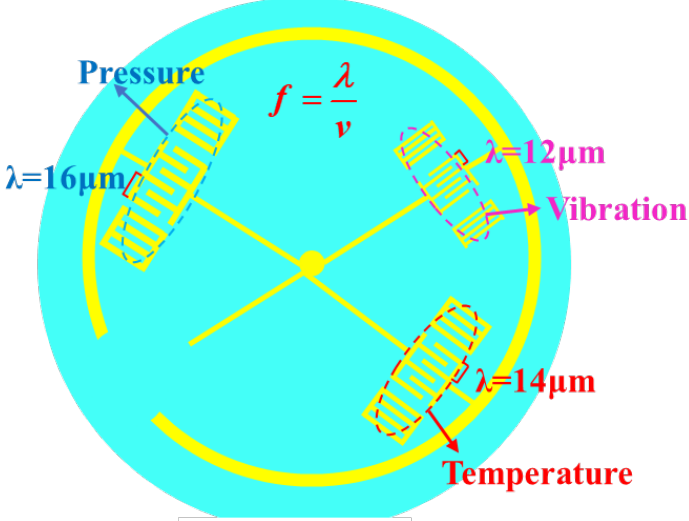
Figure 9. Frequency division design diagram of each parameter.